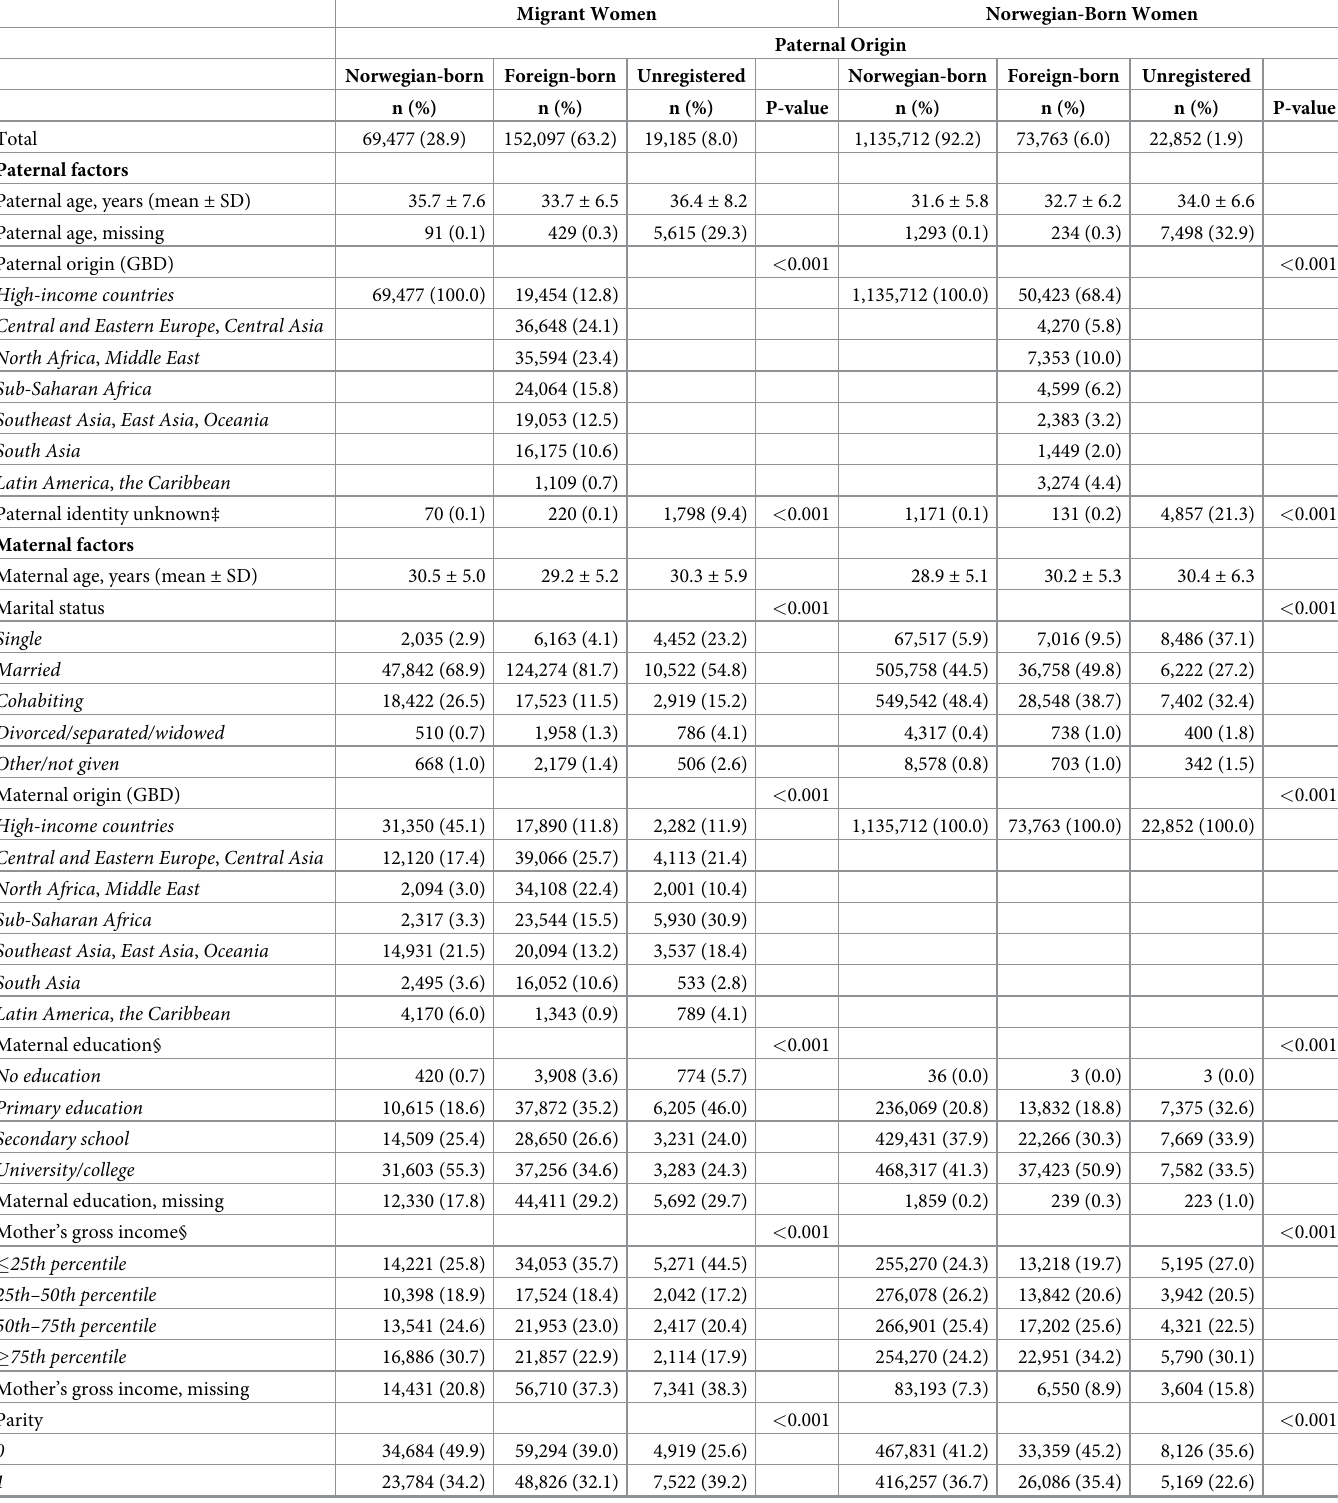
Table 1. Background characteristics by paternal origin in births to migrant (n = 240,759) and Norwegian-born (n = 1,232,327) women in Norway